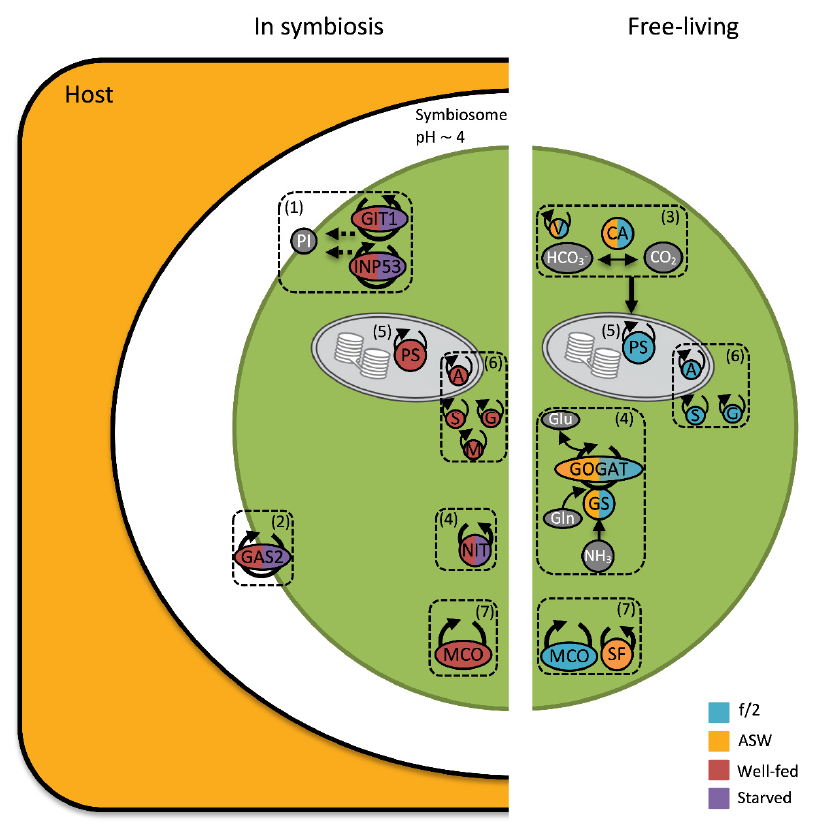
Figure 3. Conceptual diagram of the cellular processes under varying degrees of B. minutum compatibility. Coloured proteins were significantly more abundant in the colour-coded treatments. Grey = metabolites/solutes; Purple = Starved; Red = Well-fed; Orange = ASW; Turquoise = f/2. (1) Proteins involved in phosphoinositol (PI) manipulation, including GIT1 and INP53 were more abundant only in hospite , potentially for preventing host autophagy, and aiding communication and cell recognition. (2) Cell wall modification proteins (e.g., GAS2) were increased in symbionts regardless of nutritional state. (3) B. minutum carbonic anhydrase (CA) and vacuolar proton pumps (V), which work in harmony to convert bicarbonate ions (HCO 3- ) to carbon dioxide (CO 2 ), were abundant in both free-living treatments. CO 2 can be further used for photosynthesis. Upregulation of algal CAs and V-Type ATPase in the free-living state might be a response to a lack of readily available CO 2 provided by the host CAs and proton pumps when in hospite. (4) Ammonium is as- similated by B. minutum via the GS/GOGAT pathway; however, proteins associated with this pathway increased only in the free-living state, likely because the host controls the flow of nitrogen to its symbionts when in hospite . Moreover, nitrilase (NIT), which is involved in hydrolysing nitrile compounds for ammonia, only increased in abundance when in hospite , possibly as a response to nitrogen limitation inside the host. (5) Photosystem (PS) I and II proteins involved in light har- vesting, as well as chloroplastic electron transport proteins, were highly increased in abundance in the nutrient-enriched treatments (i.e., Well-fed and f/2). (6) Proteins involved in B. minutum anti- oxidant mechanisms such as ascorbate peroxidase (A), superoxide dismutase (S), and glutathione s-transferase (G) were more abundant in high nutrient treatments (i.e., Well-fed and f/2), poten- tially as a cellular response for maintaining high rates of photosynthesis/respiration. Moreover, metacaspase-1B (M), which is involved in oxidative stress and apoptosis, was only abundant in the